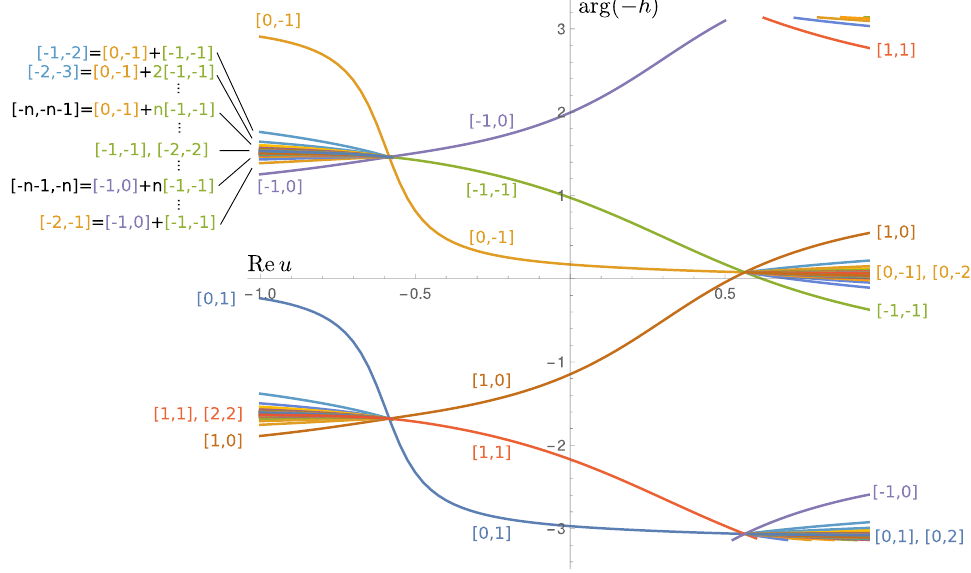
. The horizontal axis is Re( u ) ; Figure 2 . The BPS walls when we fix Λ = 1 , m = 0 , Im( u ) = i 10 the vertical axis is arg( − ~ ) ∈ [ − π, π ] . There are 2 special points at around u 0 . 6 + i and 1 ≈ − 10 where the wall of marginal stability is encountered. For Re( u ) ∈ ( u ) (strong u 2 ≈ 0 . 675 + i 1 , u 2 10 coupling) we have 3 hypermultiplets and their antiparticles, so there are 6 walls in total shown in this region. For u < u or u > u (weak coupling), we have infinitely many hypermultiplets. 1 2 The hypermultiplet walls accumulate around the vectormultiplet wall. We list the electromagnetic charges of the particles next to their corresponding